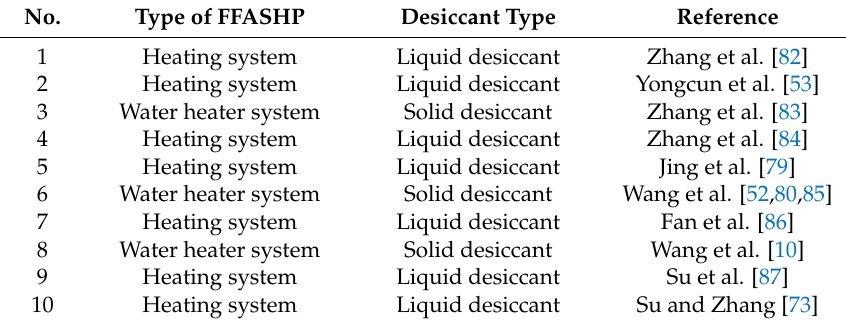
Table 3. Type of frost-free air-source heat pump (FFASHP) system based on liquid/solid desiccant.